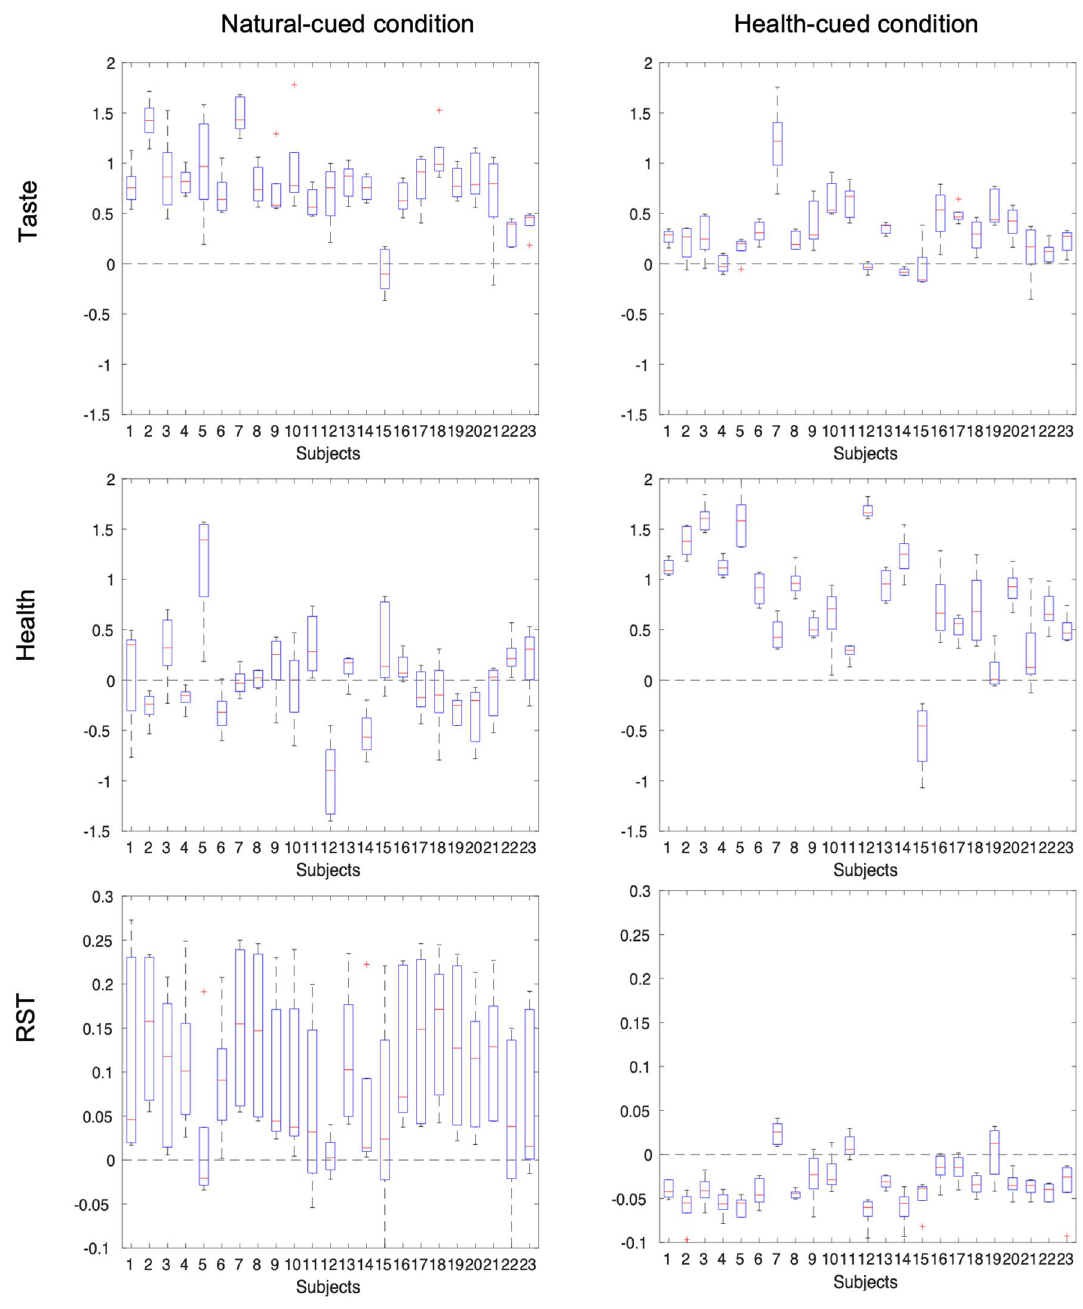
Figure 4. rstDDM parameters stability. The boxplots show that the values of most subject-level parameters didn’t change much across the 5 sessions. The values for the health and taste weights are given in arbitrary units, while the RST parameter is specified in seconds. However, the changes in attribute weights on the drift rate over time/experience were significantly greater in the natural-cued condition compared to the health-cued condition. We address the high variability of the RST parameters in the natural-cued condition further in the discussion